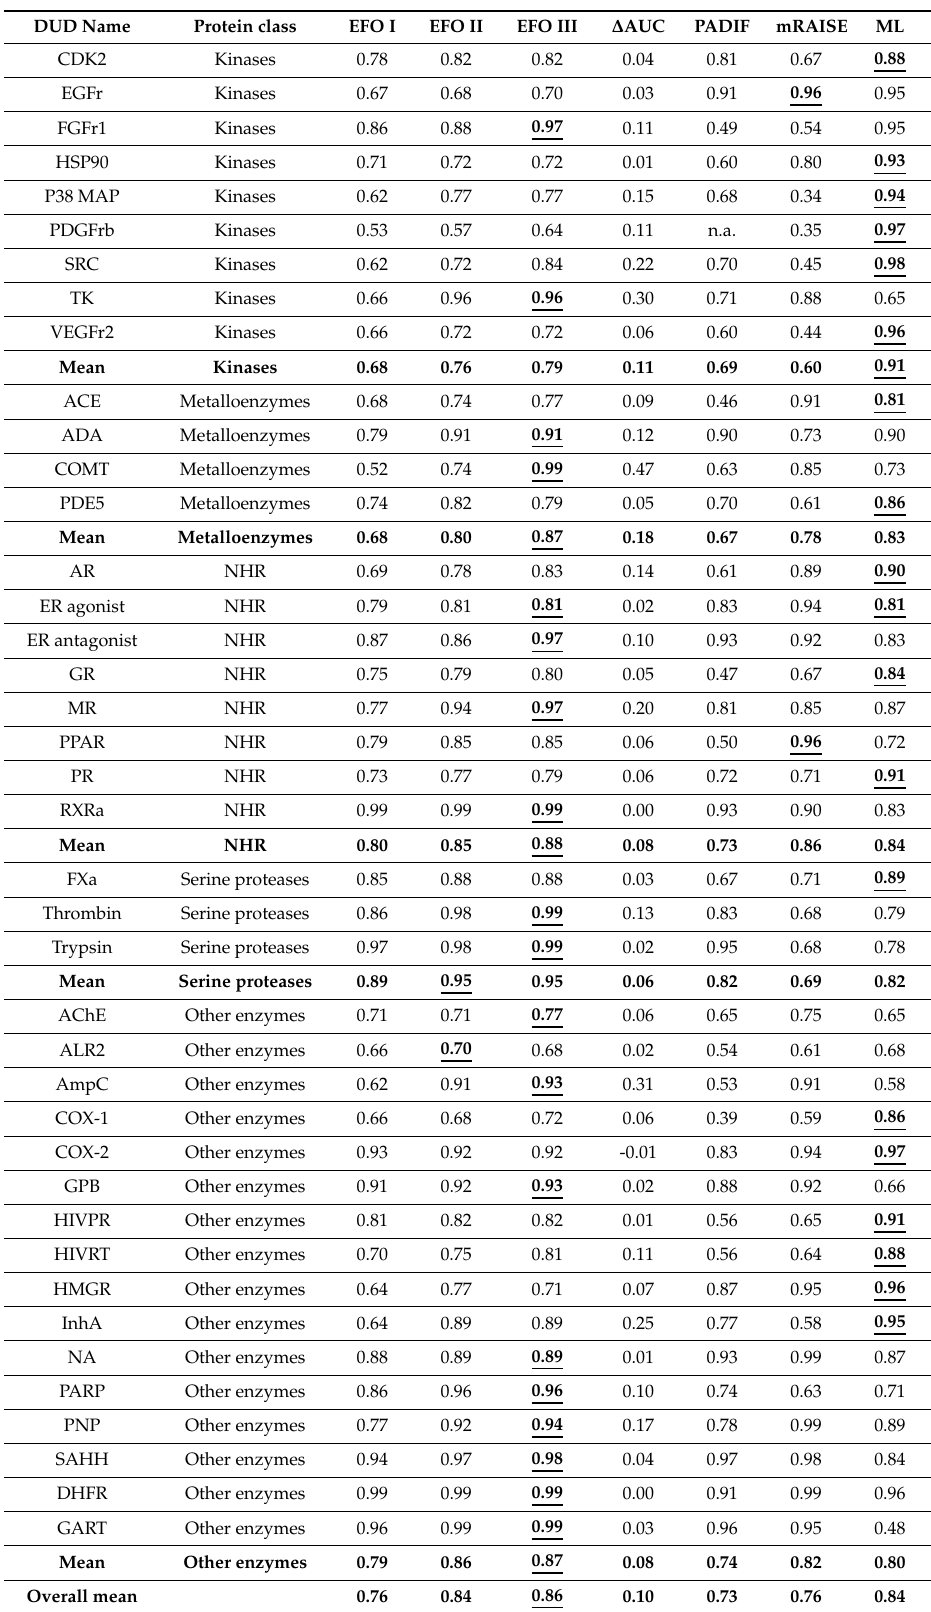
Table 4. Comparison of the AUC averages as generated by the EFO algorithm with one (EFO I), two (EFO II) and three (EFO III) variables with those reported in the three reference studies based on interaction fingerprints (PADIF [7]), pharmacophore mapping (mRAISE [28]) and machine learning-based scoring (ML [26]). ∆ AUC compares the AUC averages as obtained with one and three variables (EFO I vs. EFO III) and thus encodes the overall enhancement exerted by the here described consensus strategy. Underlined values indicate the best